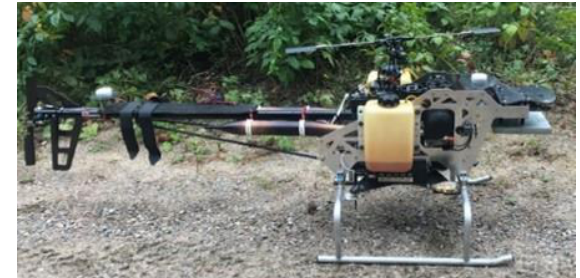
Figure 3. UAV platform flown in 2018 flight campaign